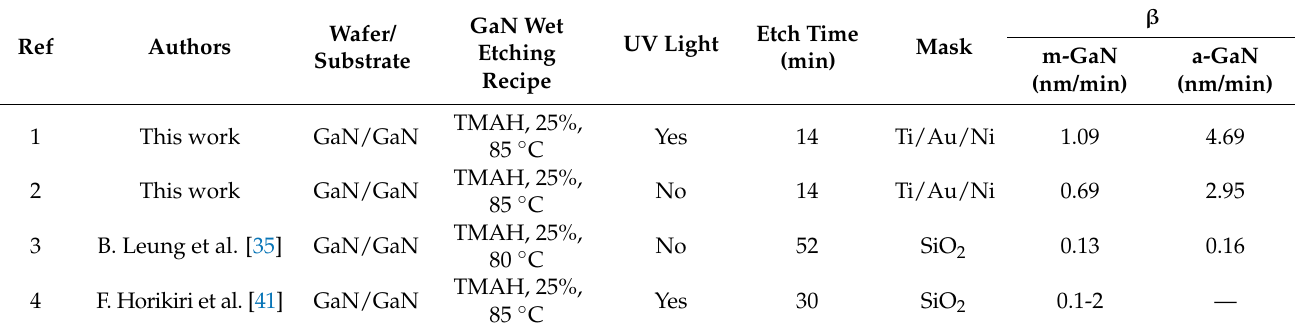
Table 1. GaN crystallographic etching rate ( β ) of m-GaN and a-GaN planes in TMAH for different wet etching setups.